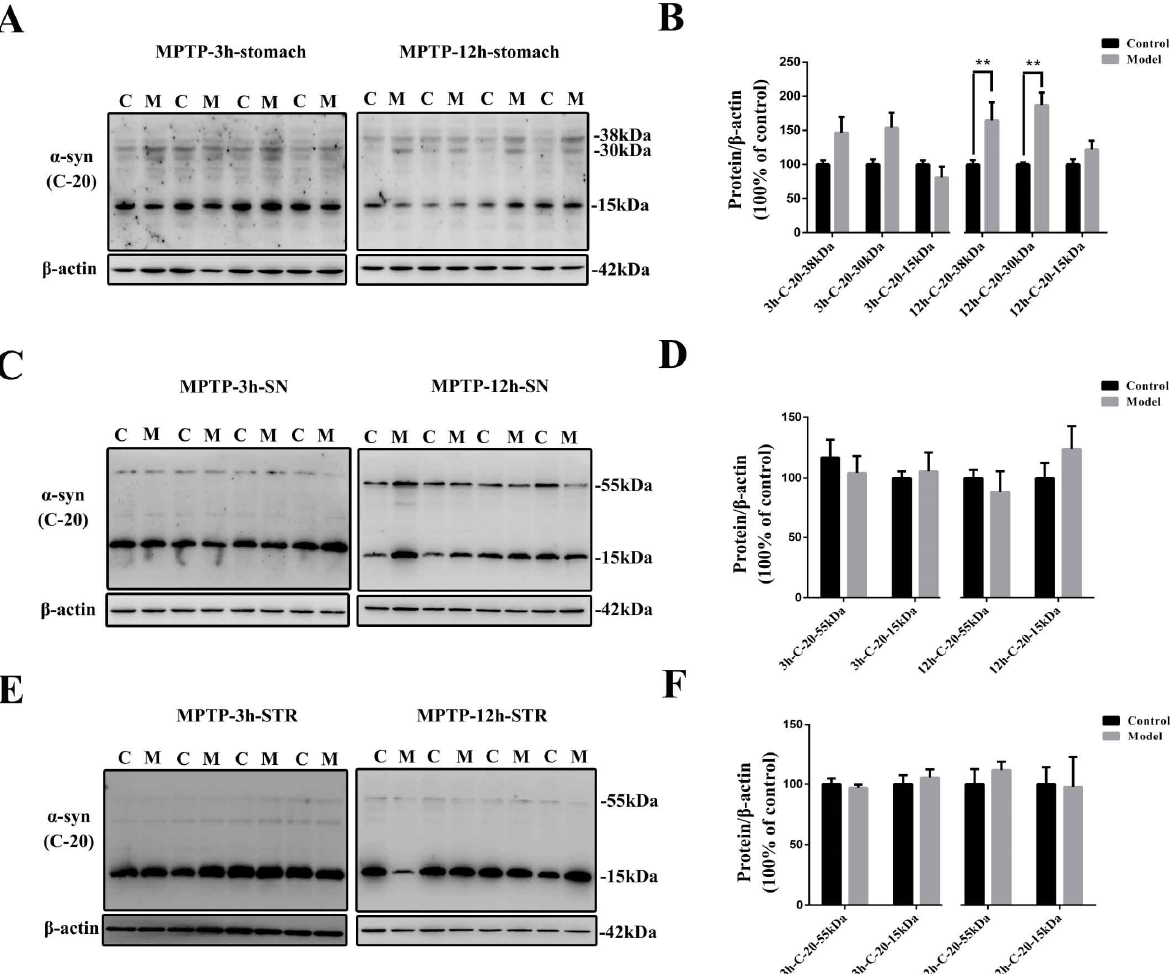
Figure 9. The stomach appears to develop synucleinopathies induced by MPTP before the SN and the STR. Representative protein bands of ( A ) stomach, ( C ) SN, and ( E ) STR dissected from 3 h, and 12 h MPTP-exposed mice detected using anti-α-syn (C-20) and β-actin antibodies are shown. Histograms representing the quantitative analysis of different forms of α-synuclein levels in the ( B ) stomach, ( D ) SN, and ( F ) STR from 3 h and 12 h MPTP-exposed mice detected by anti-α-syn (C-20) antibody normalized to β-actin protein levels are shown ( n = 4). The data are presented as the means ± SEM, ** p < 0.01 compared with the control group.